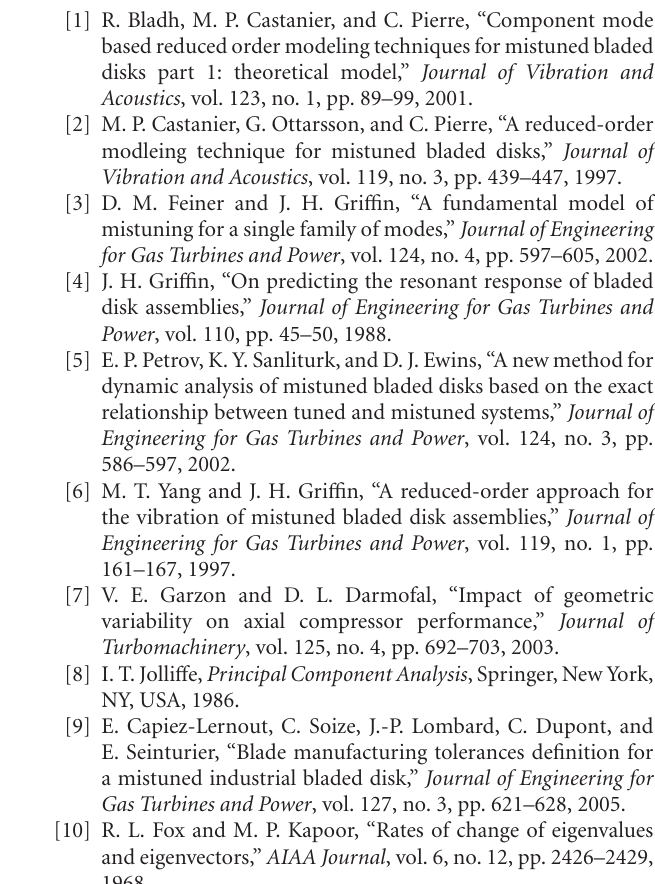
Figure 13: Forced stress prediction comparison (Mode 15).